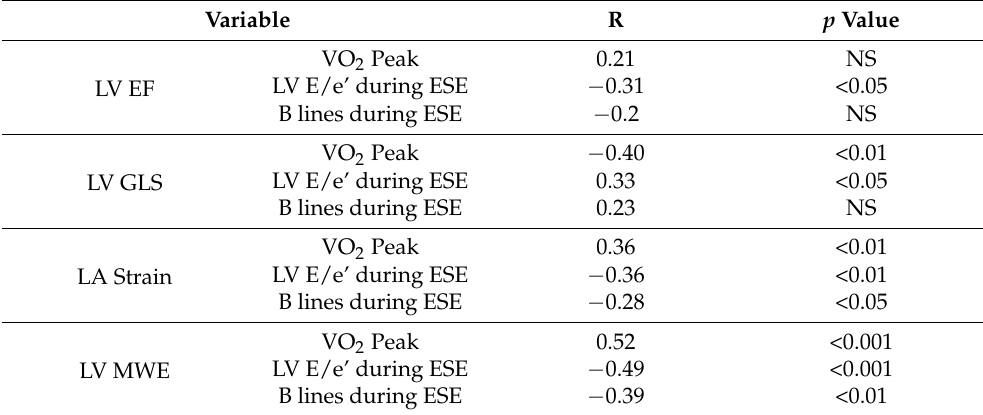
Table 5. Univariable analysis: Correlations between resting LV and LA echo indexes and functional parameters during effort in CR